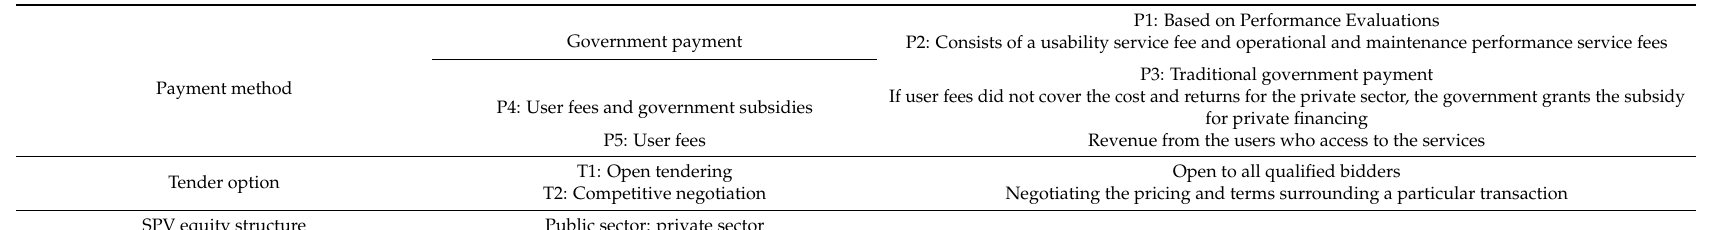
Table 1. Explanation of the payment methods, tender options, and Special Purpose Vehicle (SPV) equity structure.